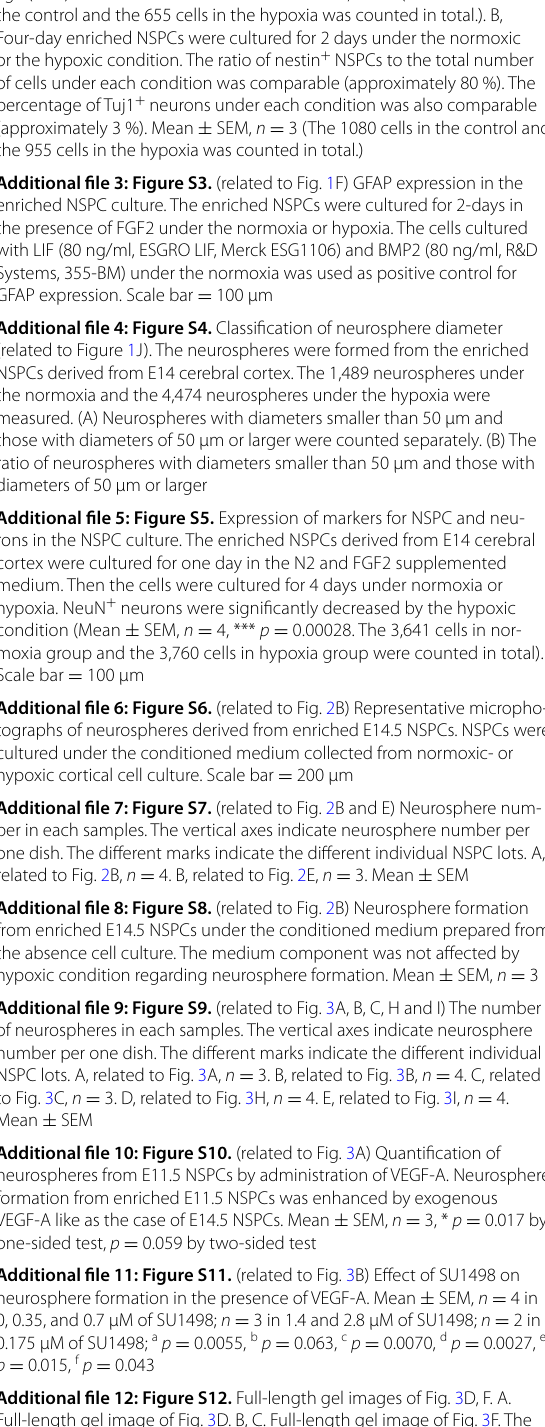
Additional file 2: Figure S2. (related to Fig. 1F) Ratio of NSPCs and neurons to total cells in the 2-day cultures of freshly isolated cortical cells and enriched NSPCs. A, Freshly isolated cortical cells were cultured